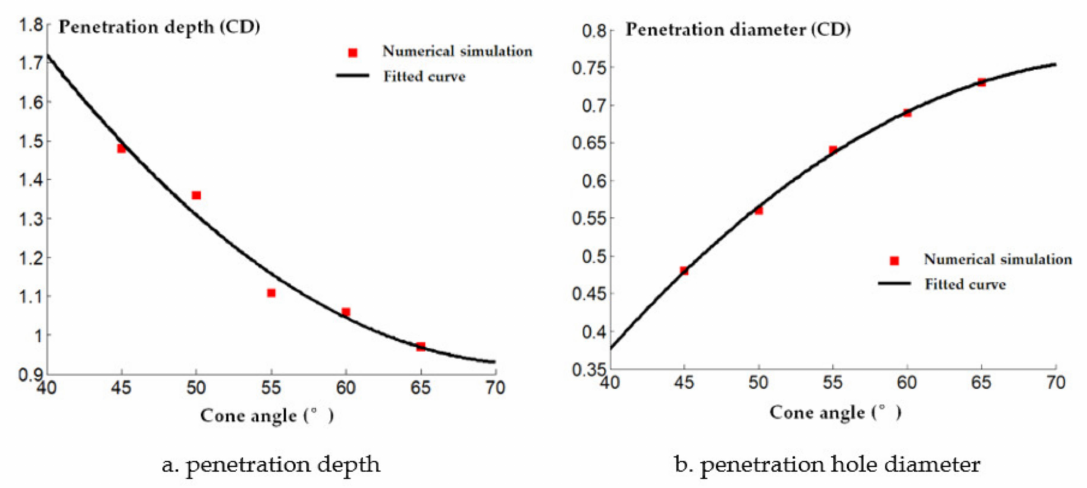
Figure 11. Penetration of reactive material covers with different cone angles into a steel